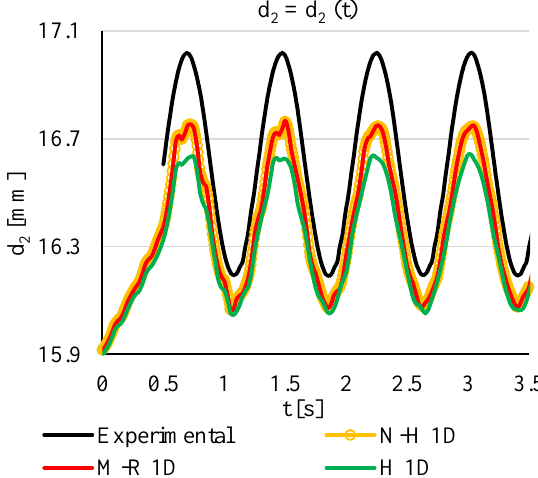
Fig. 8. Outer diameters d 2 of the thin-walled tube.